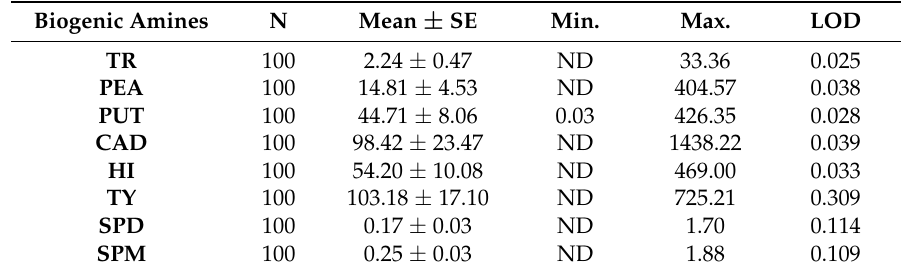
Table 3. Results of biogenic amine levels (mean ± SE, mg/kg wet weight) in herby cheese samples. Biogenic Amines